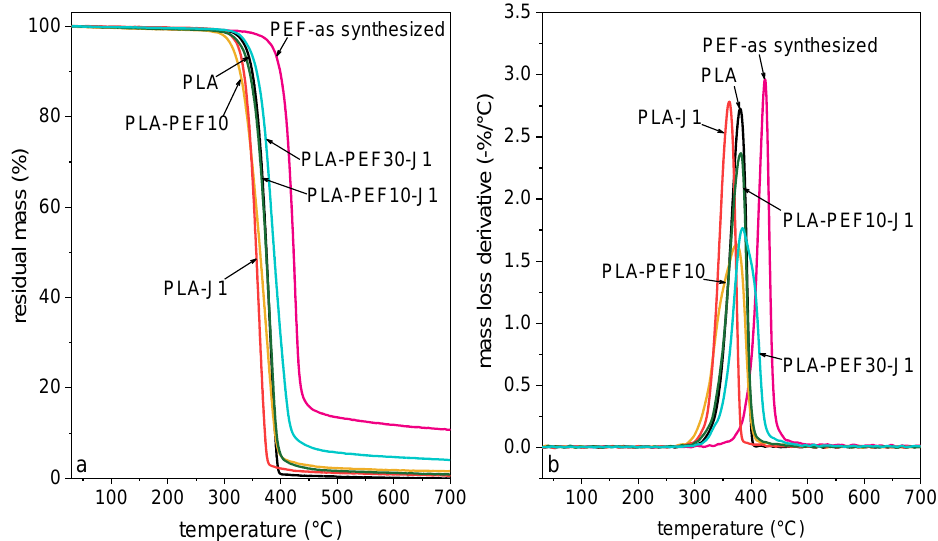
Figure 5. Representative TGA thermograms of some selected compositions. ( a ) Residual mass as a function of temperature; ( b ) mass loss derivative as a function of temperature. Table 3. Main results of the TGA tests on the prepared samples.